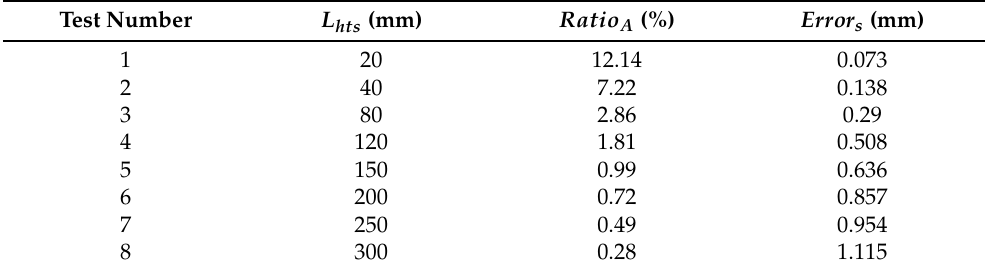
Table 2. Test results of the distance: L hts denotes the distance between a hole and a screw, Ratio A denotes the percentage of the image area of a screw, and Error s means the positional error of the screw. Test Number L hts (mm)